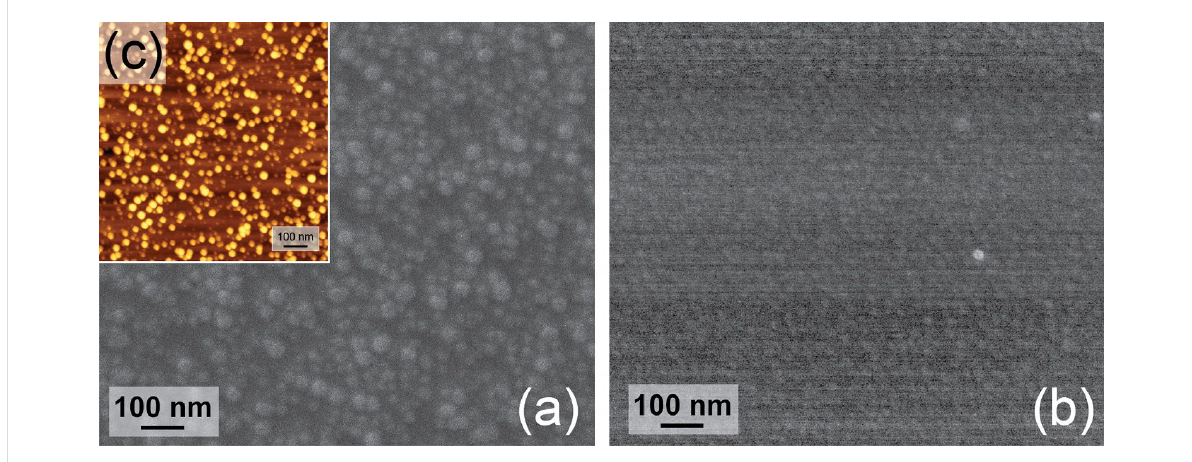
Figure 9: SEM top views of Pd deposits after 100 ALD cycles onto (a) as-grown NiO and (b) reduced NiO films on Si substrate. (c) AFM image of Pd clusters onto as-grown ALD NiO.